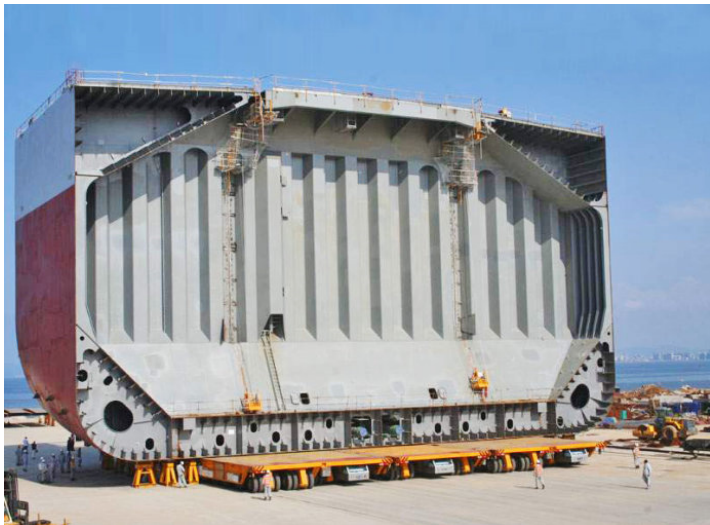
Figure 1. A heavy and huge ship block is being transported (tireworld.com.cn).